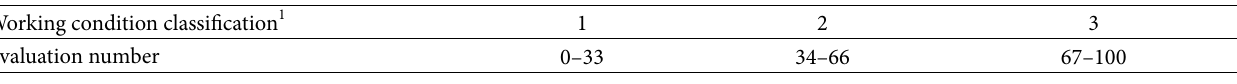
Table 6: Classification of airport asphalt pavement overlay combination working condition (regardless of external environment impact).